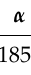
Table 2. The determined geometry parameters of the planar bistable lattice. α